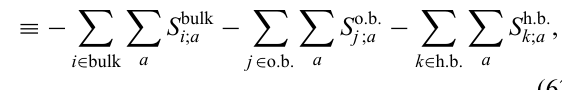
FIG. 29. The application of a transversal CZ along a codimension-1 submanifold (gray) effectively sweeps the s 2 domain wall across the submanifold and attaches the wall onto the ( m 1 , m 2 , m 3 ) -boundary, generating a codimension-2 bound- ary ( m 1 e 2 , e 1 m 2 , m 3 ) nested on the ( m 1 , m 2 , m 3 )